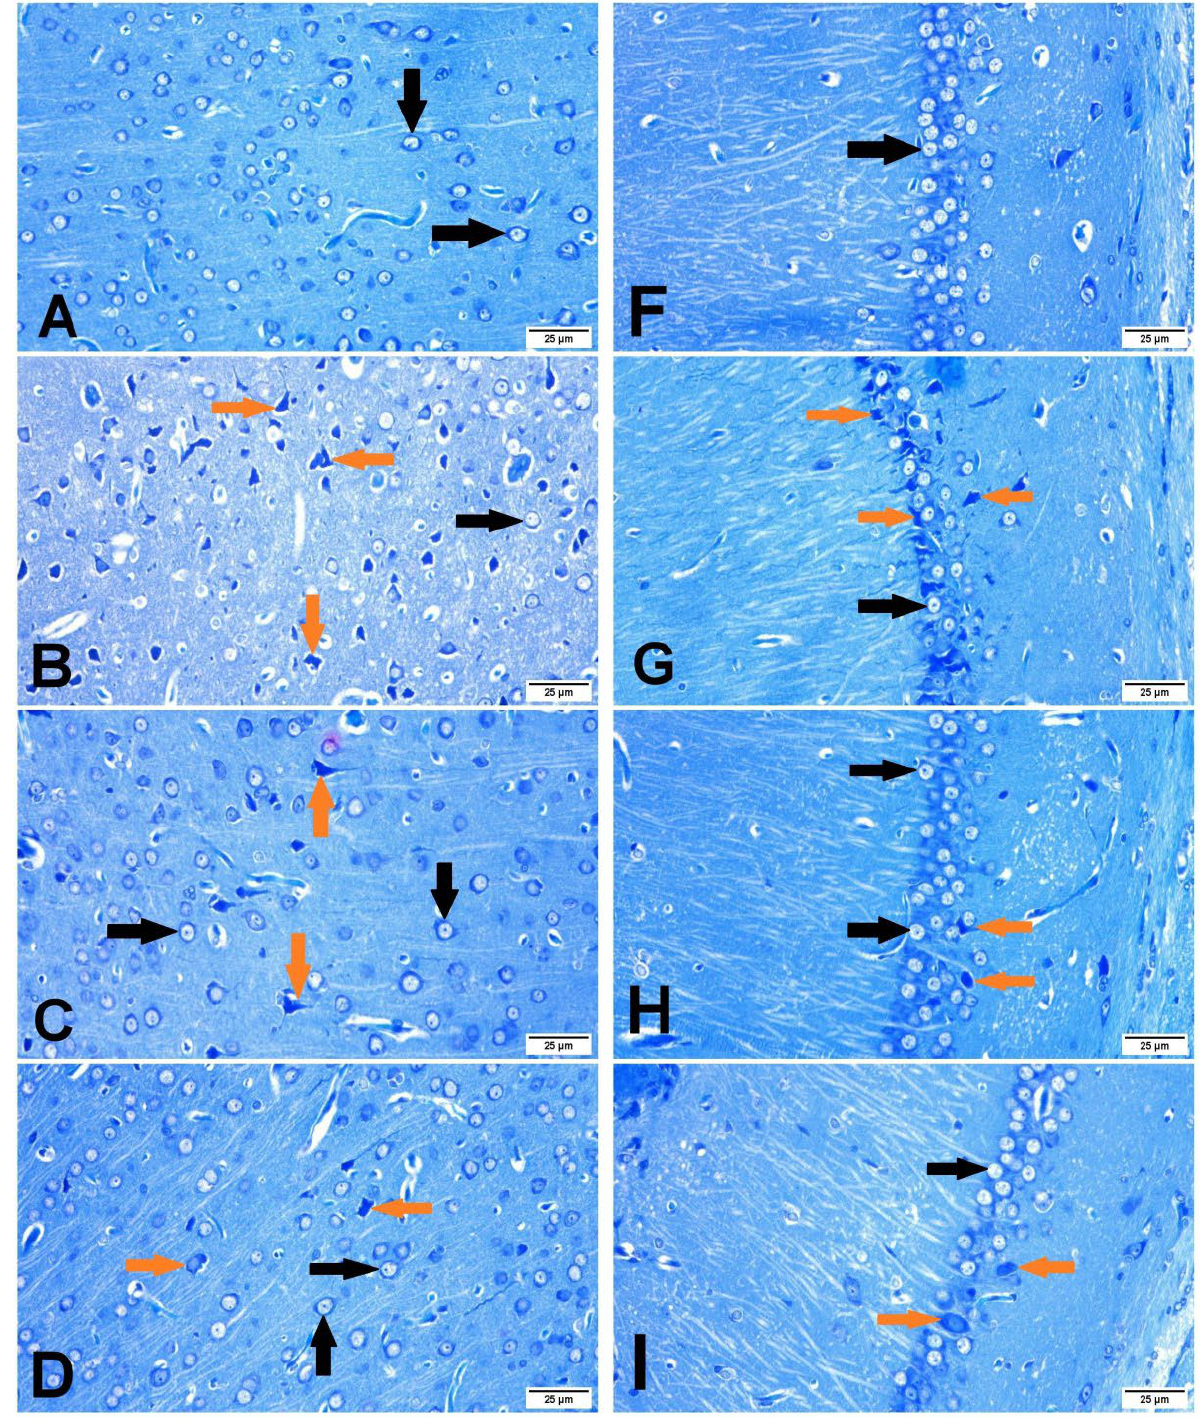
Figure 6. Brain sections stained with toluidine blue, showing the effect of beta-carotene on neuronal cell count in cerebral cortex and hippocampus region in focal cerebral ischemia-reperfusion model × 400. Intraneuronal cell (black arrows) and non-intact neuronal cell (green arrows). ( A – D ) Cerebral cortex. ( F – I ) Hippocampus. ( A , F ) Sham group. ( B , G ) I/R control group. ( C , H ) β CAR-10. ( D , I ) β CAR-20 group. Scale bar 25 µm.